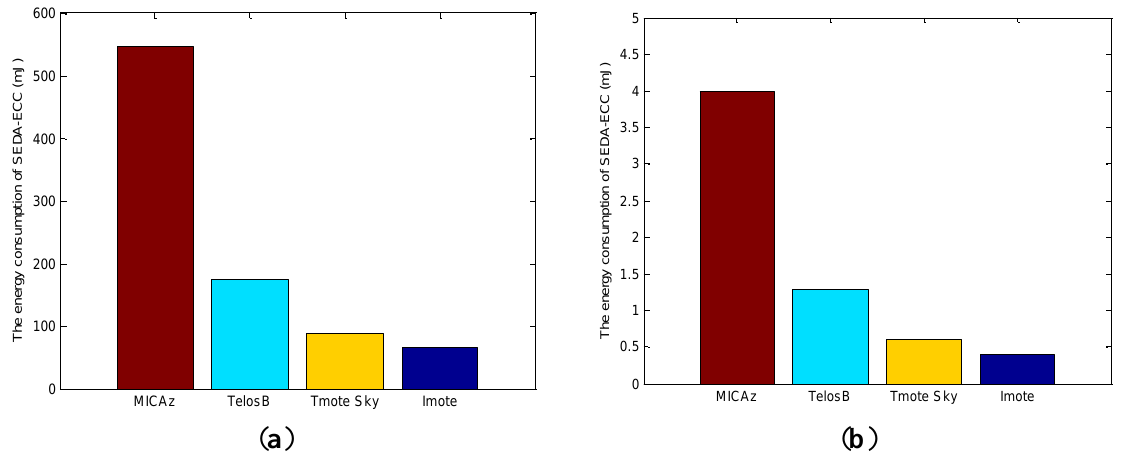
Figure 8. The energy consumption of SEDA-ECC in different sensor devices; ( a ) encryption consumption and ( b ) aggregation